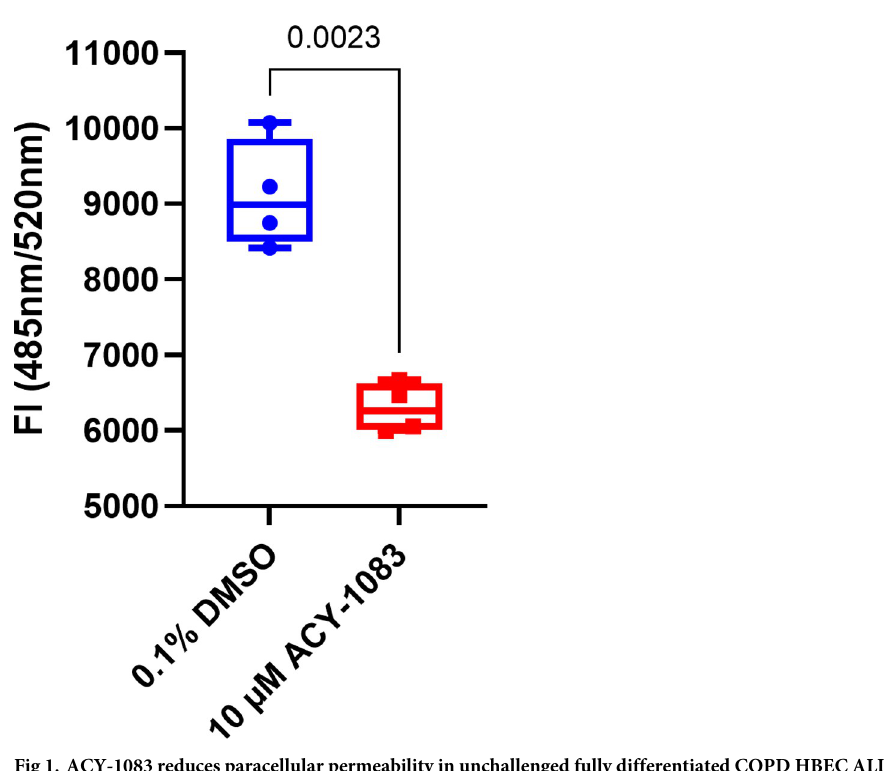
Fig 1. ACY-1083 reduces paracellular permeability in unchallenged fully differentiated COPD HBEC ALI cultures. Graph shows the fluorescence intensity of FITC-labelled dextran (4kDa) passed through cell layers to the basolateral side. Box plot with dots representing the average of three individual replicates for each of 4 COPD donors and whiskers showing min and max. Statistical analysis was performed using two-tailed paired t-test.